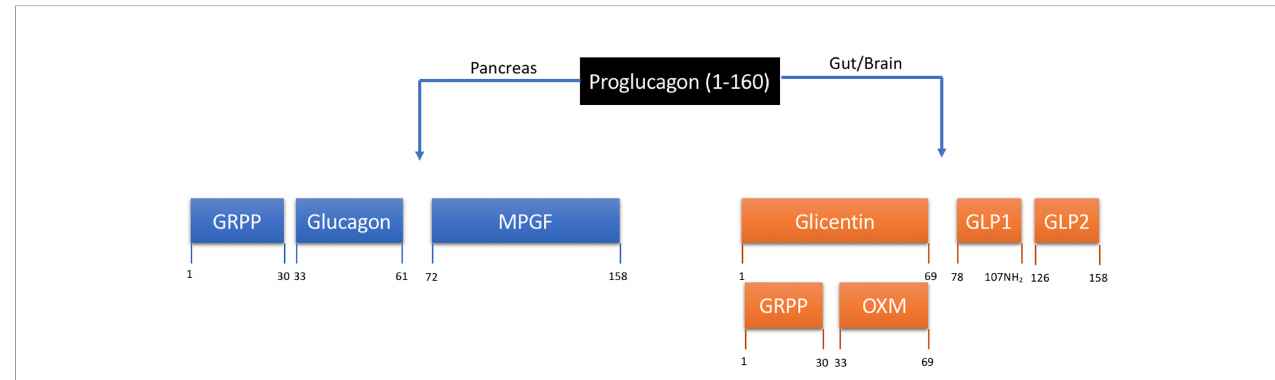
FIGURE 1 | Tissue-speci fi c processing of proglucagon. Proteolytic cleavage is tissue speci fi c and regulated by prohormone convertases (PC) 1 and 2. In the pancreas, PC2 results in the formation of glucagon, glicentin-related pancreatic peptide (GRPP) and the inactive fusion protein major proglucagon fragment (MPGF). In the gut and brain, PC1/3 results in the formation of glicentin, GLP-1 and GLP-2. Glicentin is further processed to form GRPP and oxyntomodulin (OXM). Numerical annotations represent amino acid positions within the 160 amino acid proglucagon